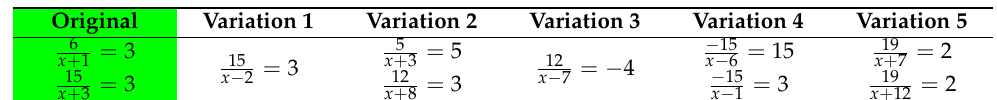
Table 11. Examples of type 10 equations and